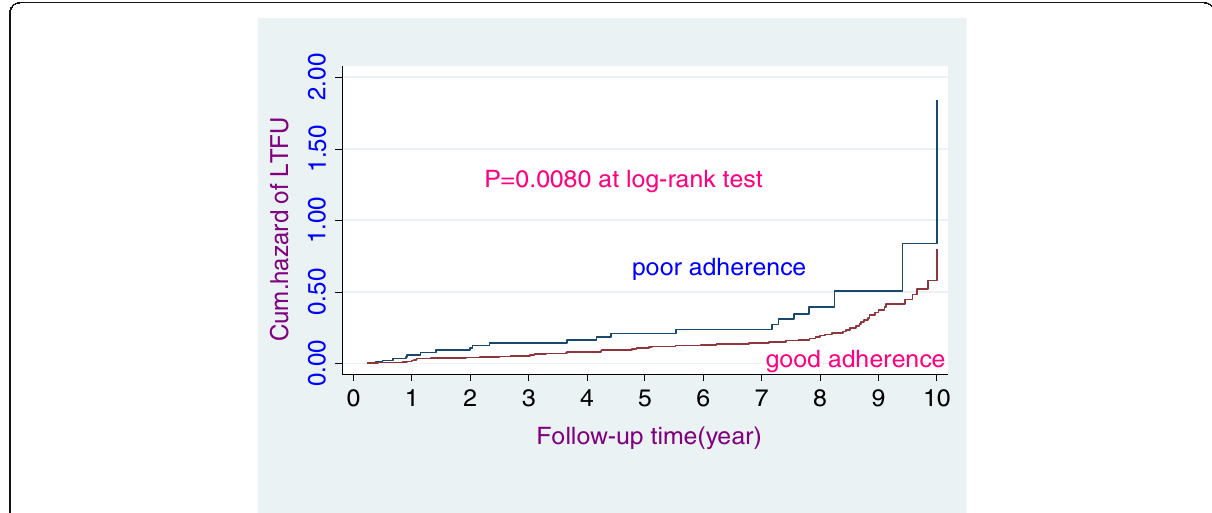
Fig. 3 The hazard rate of lost to follow-up of HIV-positive adult individuals on ART over their history of ART adherence from January 30, 2008, to January 26,